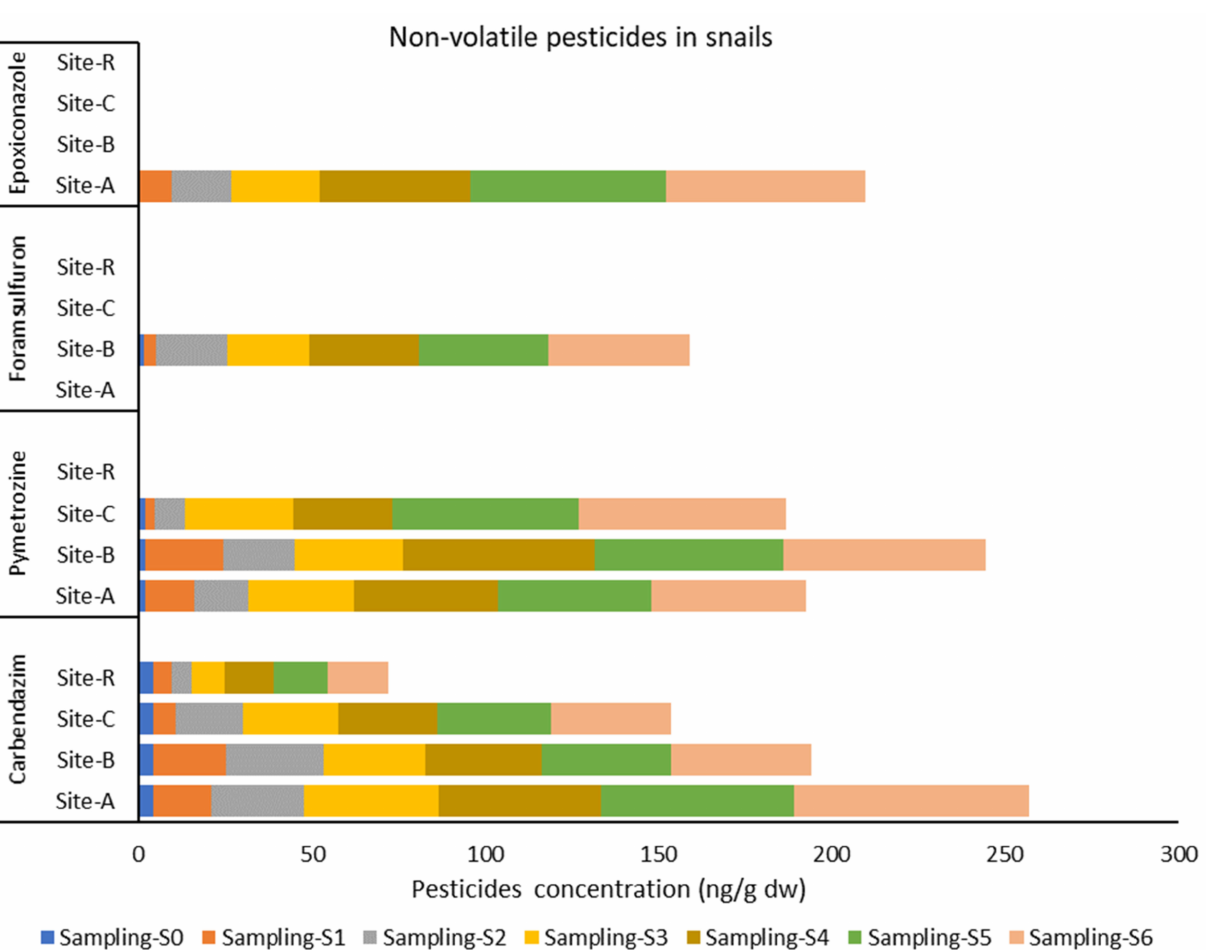
Figure 3. Concentration of non-volatile pesticides (ng/g dw) in the snails sampled from the four sampling